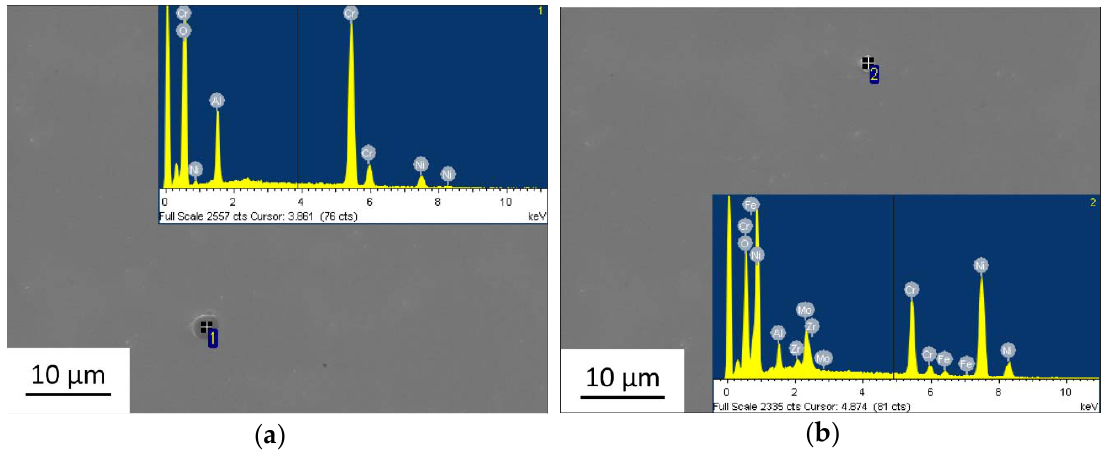
Figure 6. Scanning electron micrographs and EDX spectra: ( a ) location 1, ( b ) location 2.